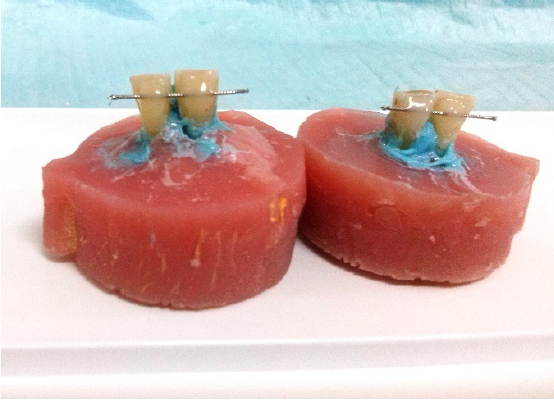
Figure 2. The prepared samples: composite group and ormocer group.